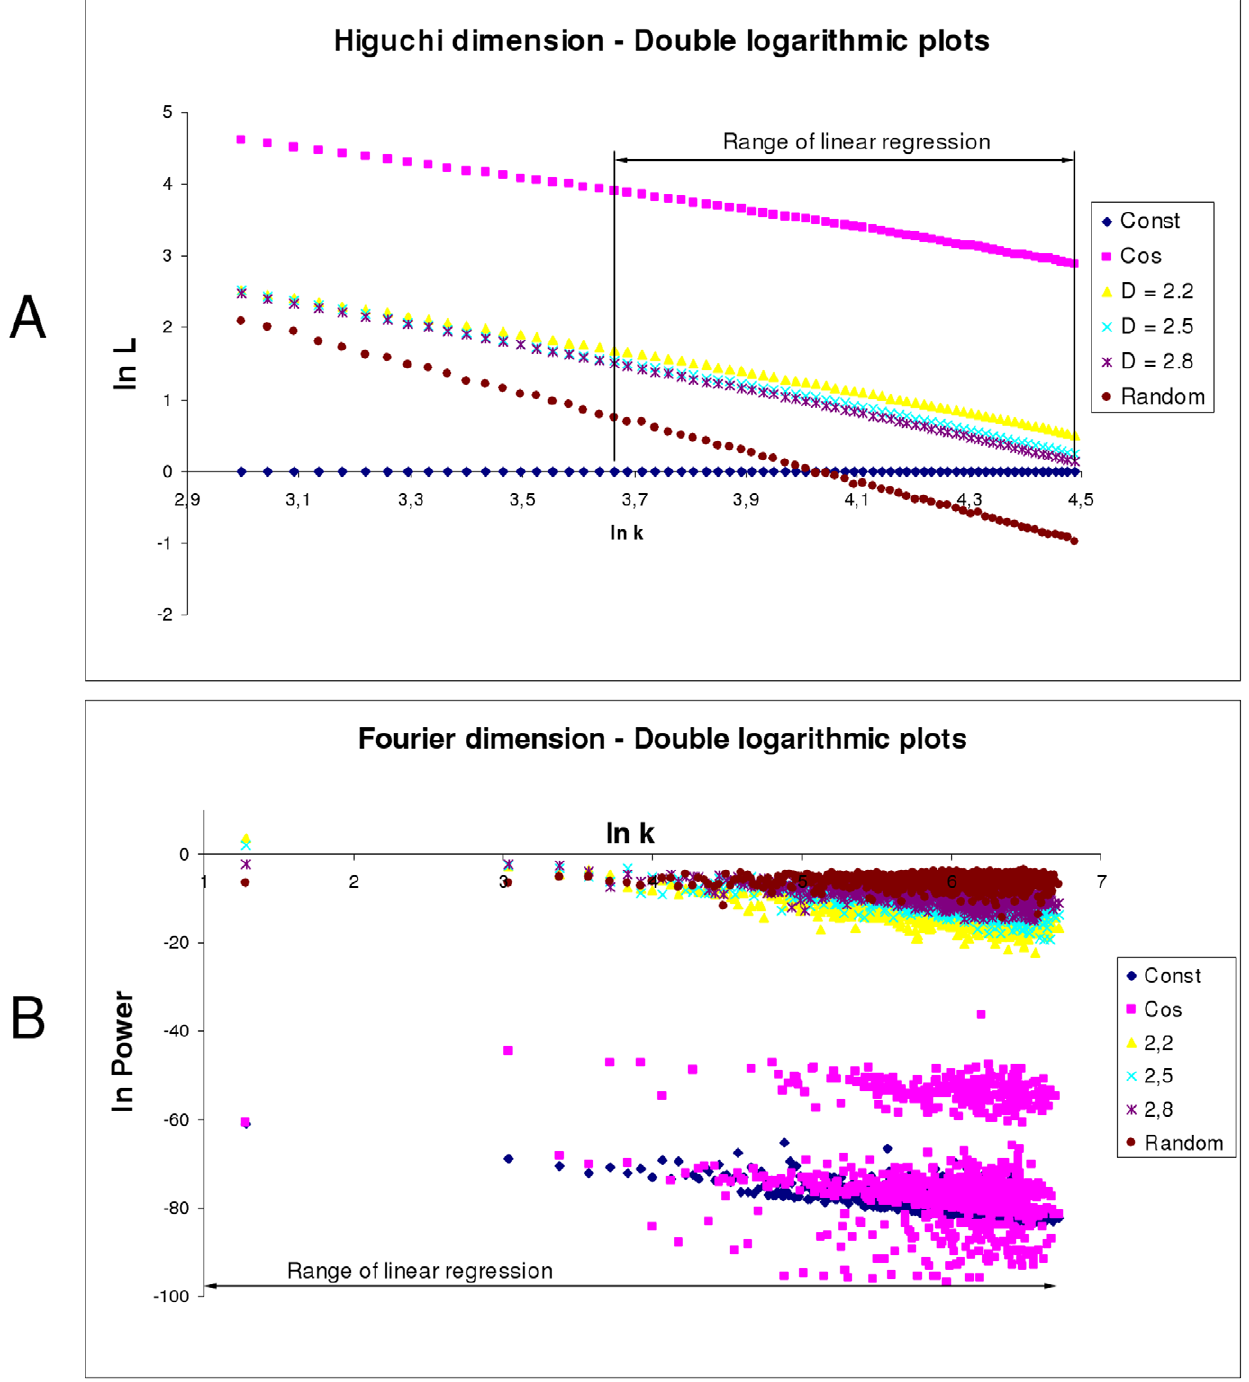
Figure 2. Double logarithmic plots of the Higuchi and Fourier dimension. The individual ranges of linear regressions are depicted. A The slopes of the Higuchi dimension show a slight tendency for two linear regions. Thus, the range of linear regression was limited to the second linear region in order to gain the best absolute dimension values. The linear regression fit the data very well, with coefficients of determination R 2 higher than 0.993. B The plot data of the Fourier dimension are highly dispersed. The coefficients of determination R 2 were about 0.332. The highest value was 0.664.